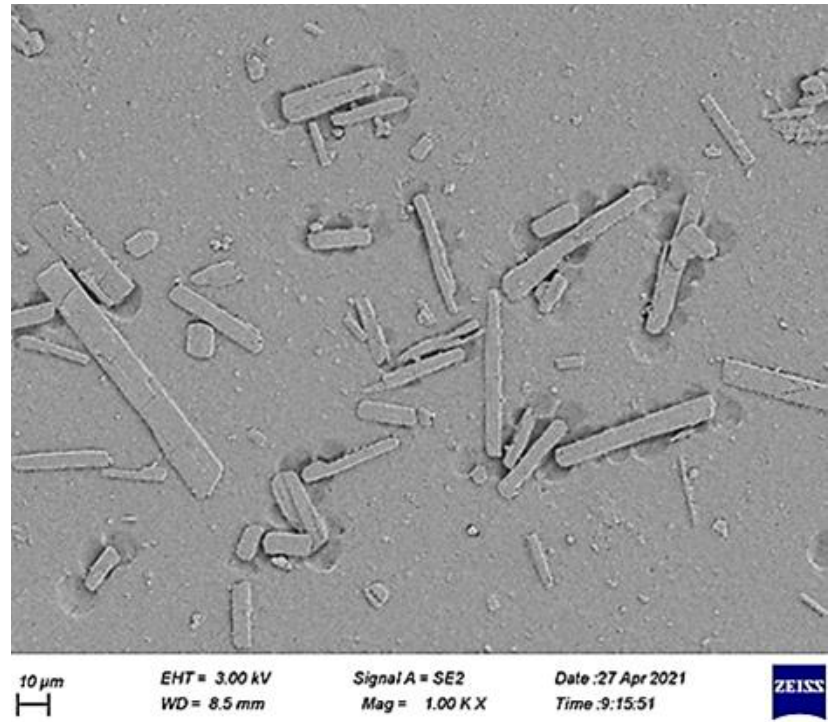
Figure 10. FESEM image of the surface of an irradiated PVC film blended with a trimethoprim-Sn complex.